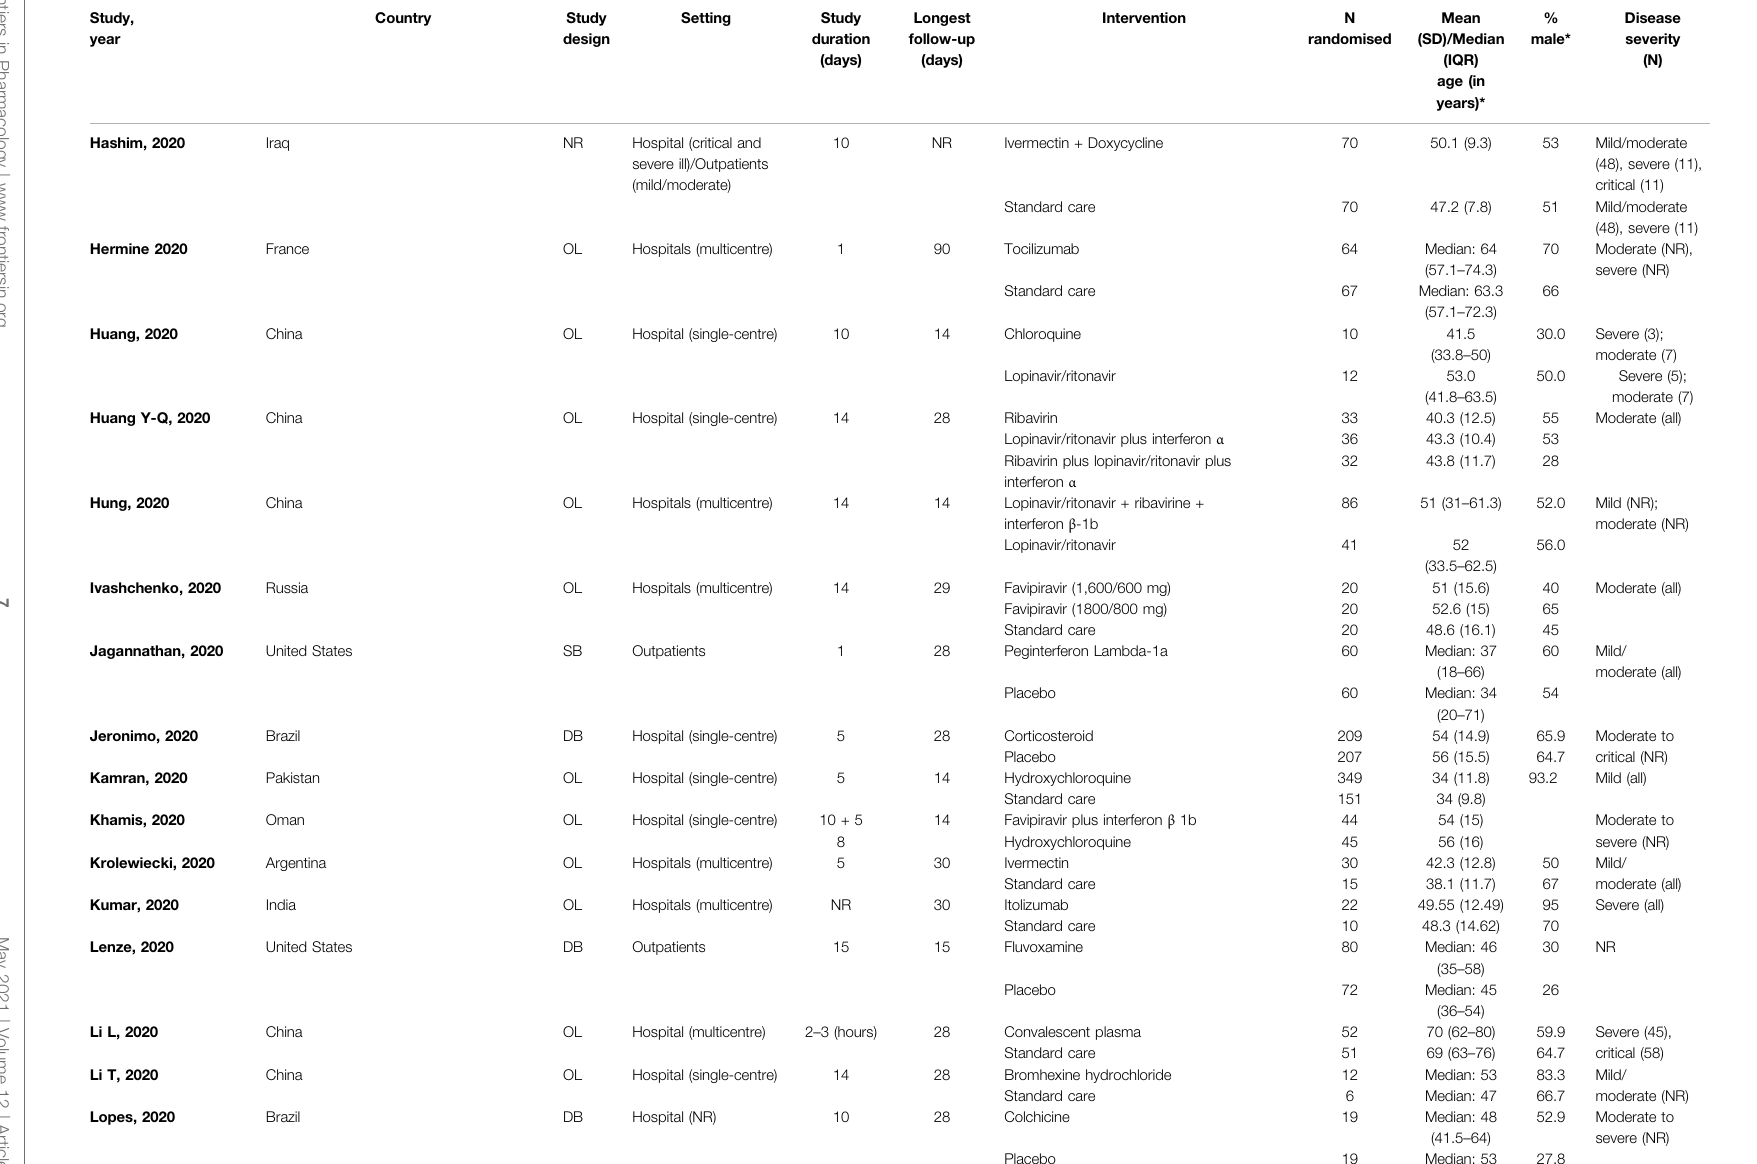
TABLE 1 | ( Continued ) Characteristics of included randomized controlled